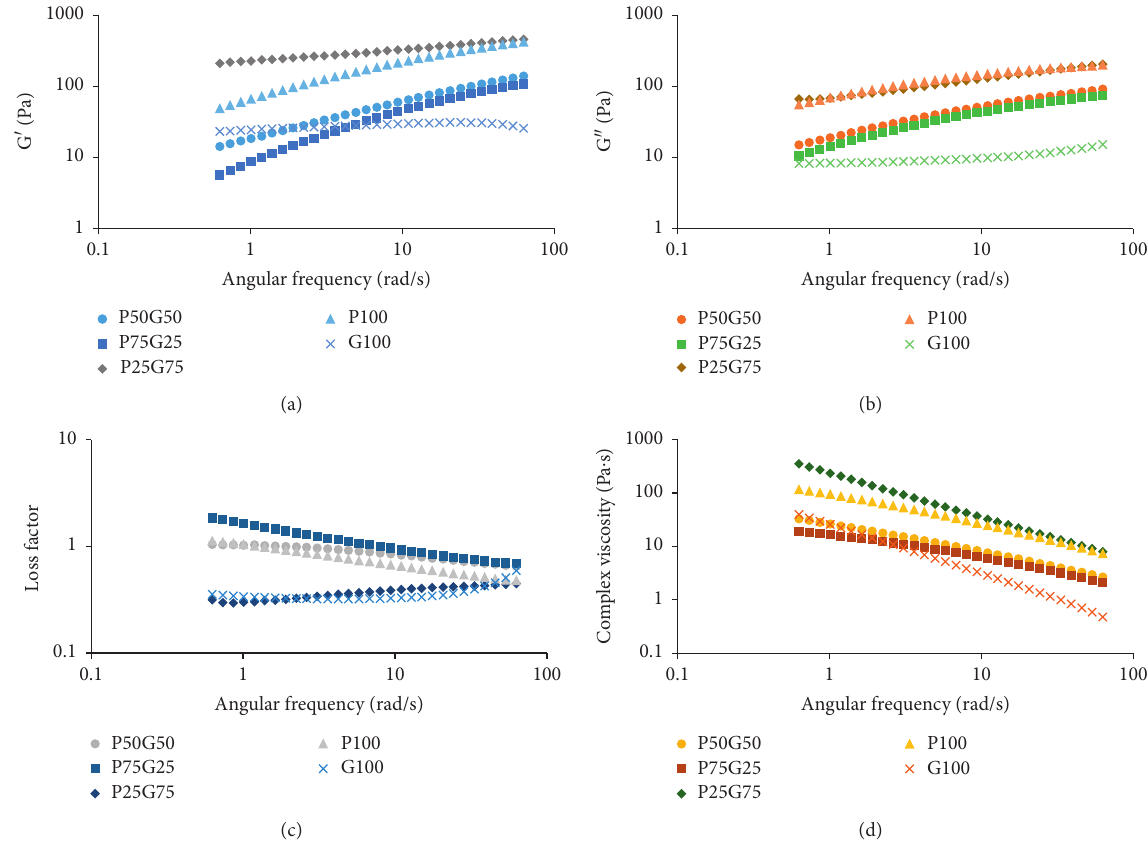
Figure 2: The effects of pectin: gum ratio on storage ( G ′ ), loss ( G ″ ) moduli, Tan δ, and complex viscosity of